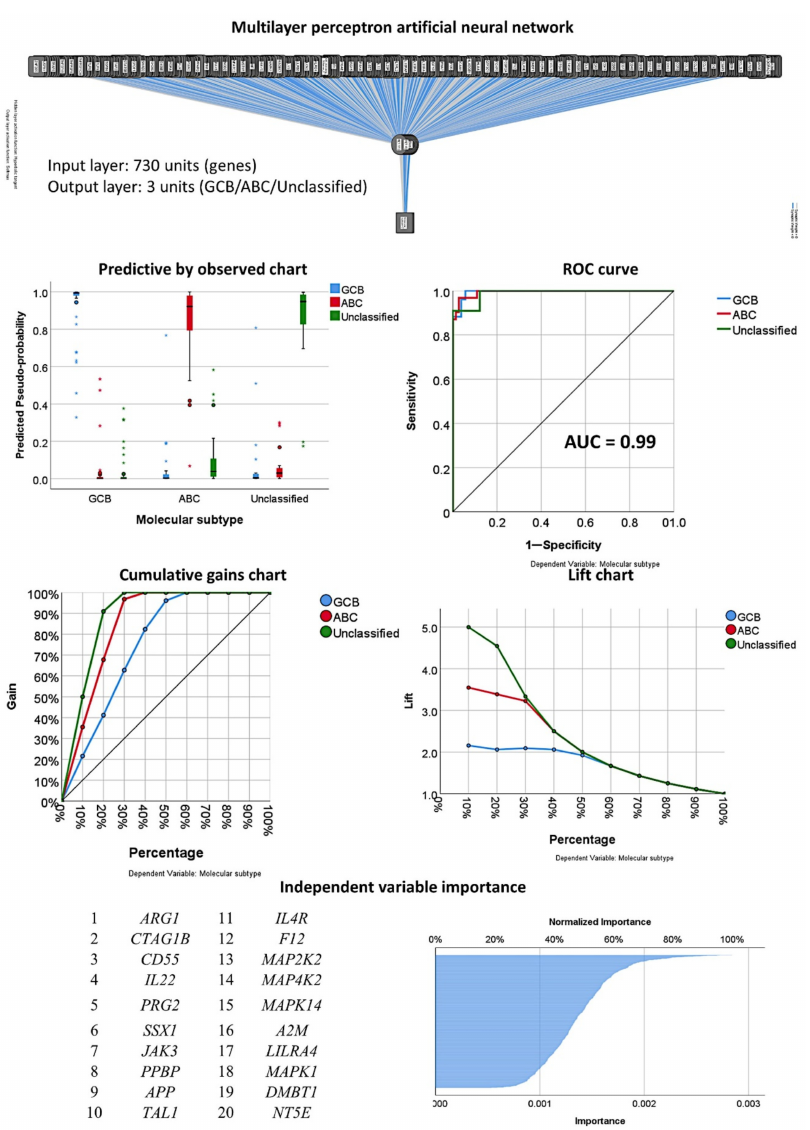
Figure 12. Multilayer perceptron analysis for predicting molecular subtypes (GCB, ABC, unspecified). The neural network predicted molecular subtypes as GCB, ABC, and Unspecified using the 730 genes of the pancancer immune oncology profiling panel. The network performance was checked using several parameters, such as the area under the curve (AUC), which had a value of 0.99. The genes were ranked according to their normalized importance for prediction, as shown in the independent variable importance chart. The top 20 genes are listed. The molecular subtypes were based on the Lymph2Cx